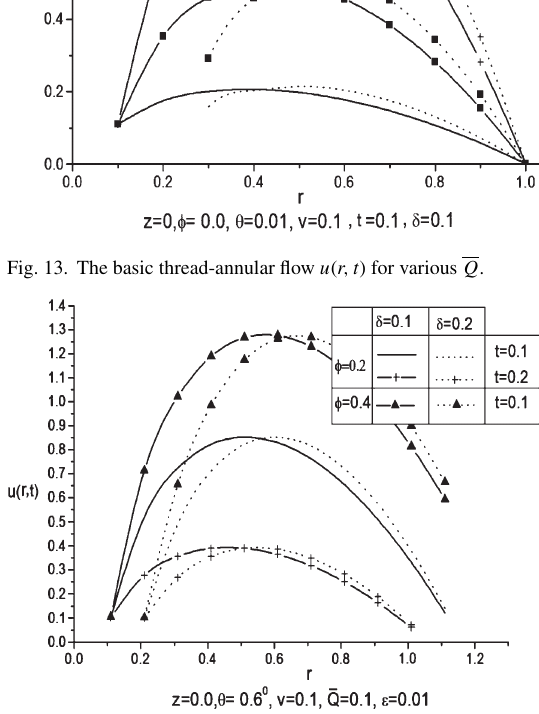
Fig. 12. Variation of outer Friction force versus t with different values (cid:2) .